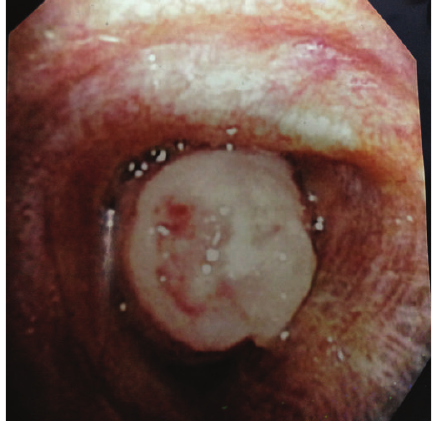
Figure 2: Bronchoscopic view of the lesion in the right bronchus intermedius.